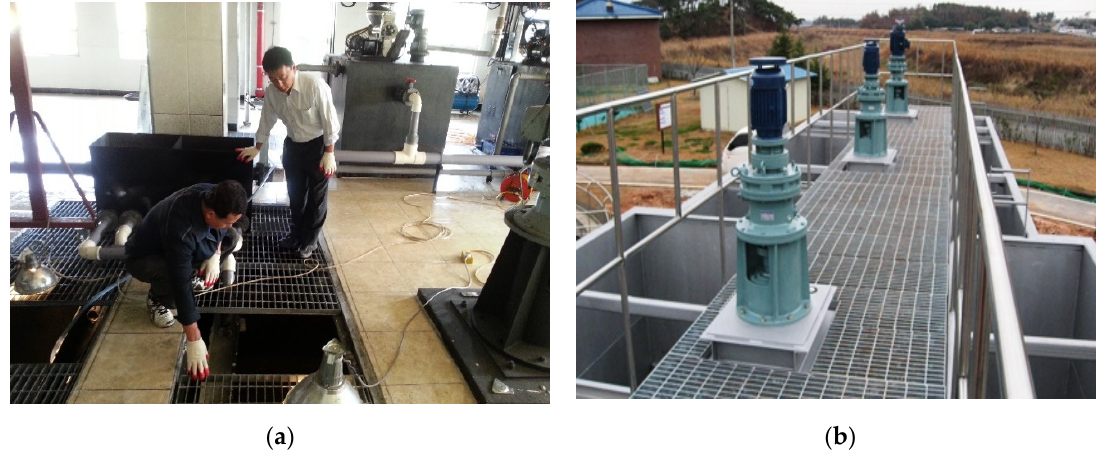
Figure3. Pictorialviewofwatertreatmentplantswithdi ff erentrapidmixingmethods. ( a )Non-powered Figure 3. Pictorial view of water-treatment plants with different rapid mixing methods. ( a ) Non- hydraulic mixing; ( b ) mechanical vertical shaft powered hydraulic mixing; ( b ) mechanical vertical shaft impellers.